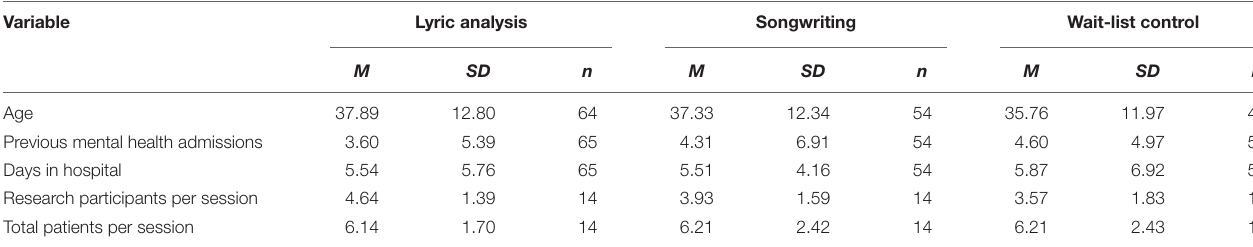
TABLE 2 | Descriptive statistics – independent variables.